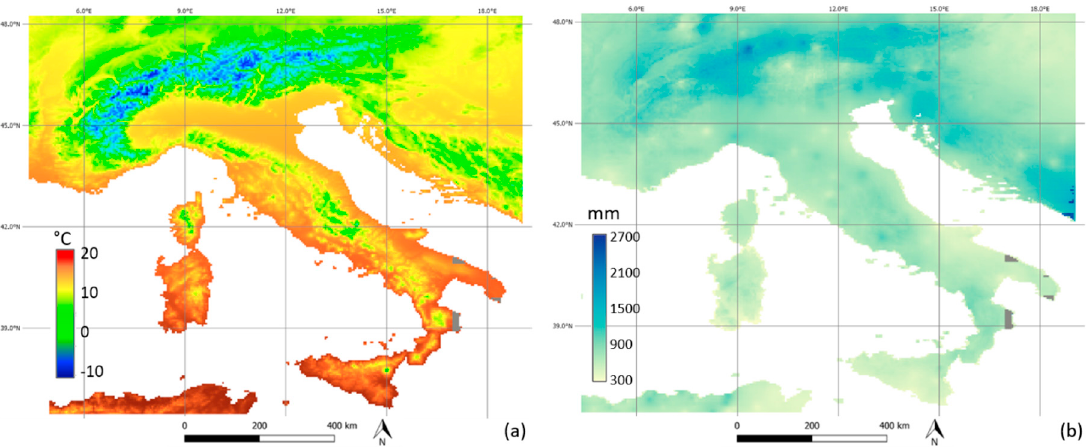
Figure 3. Annual values for: ( a ) simulated mean temperature and ( b ) total precipitation averaged over the period 1981–2018. Grey pixels indicate areas where CHIRPS data were not analyzed because of the presence of artefacts.